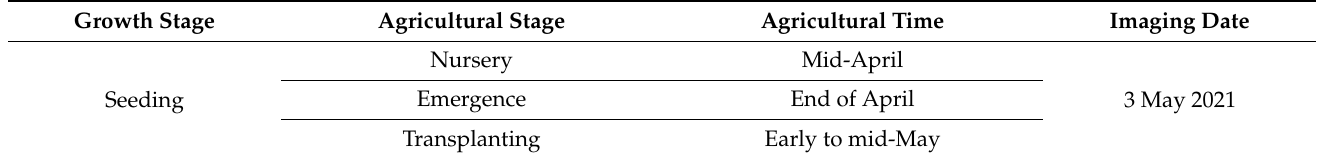
Table 1. Rice growth stages and selected images.